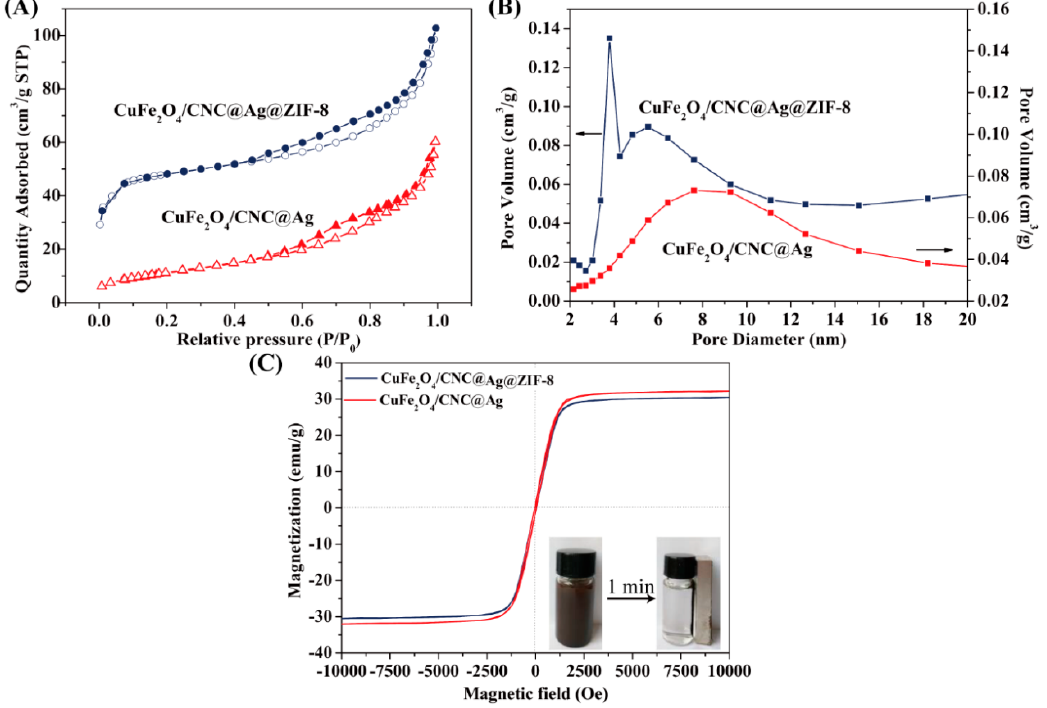
Figure 4. ( A ) N 2 adsorption-desorption isotherms; ( B ) the pore-distribution curves; ( C ) the magnetic hysteresis curves of the CuFe 2 O 4 /CNC@Ag@ZIF-8 and CuFe 2 O 4 /CNC@Ag nanocomposites (the inset shows the magnetic separation behavior of the CuFe 2 O 4 /CNC@Ag@ZIF-8 nanocomposites in the aqueous solution).